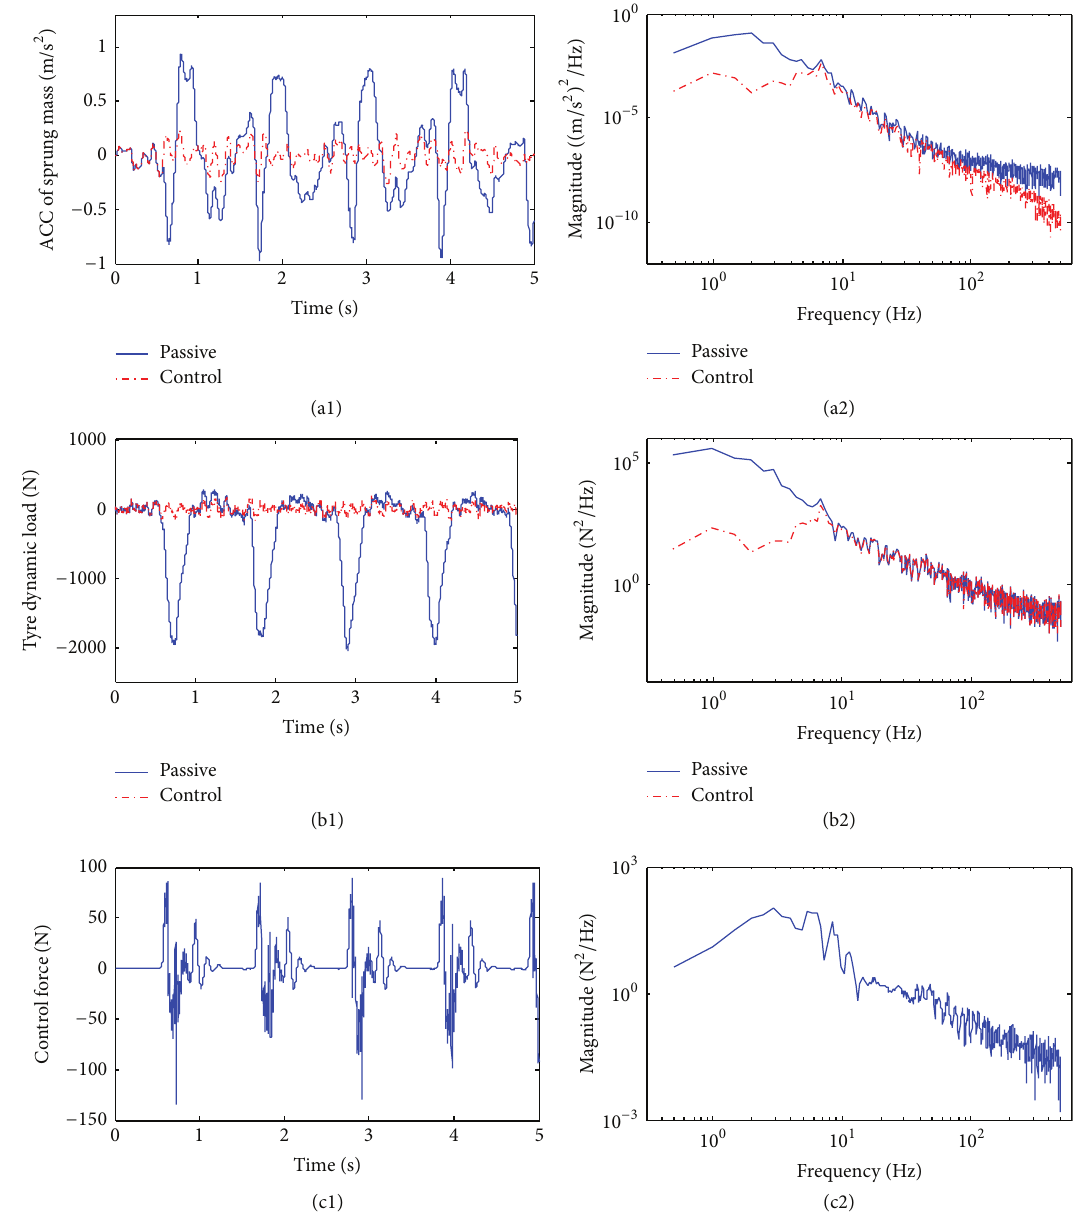
Figure 13: Suspension performance under FxLMS control at velocity 2 km/h. (a1) Time history of sprung mass acceleration. (a2) PSD of sprung mass acceleration. (b1) Time history of tyre dynamic load. (b2) PSD of tyre dynamic load. (c1) Time history of suspension control force. (c2) PSD of suspension control